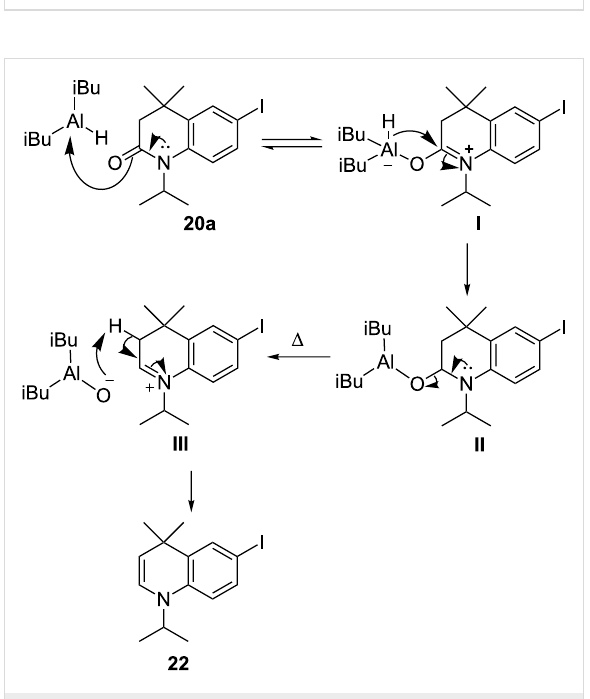
Scheme 9: Postulated mechanism for the formation of 22 using